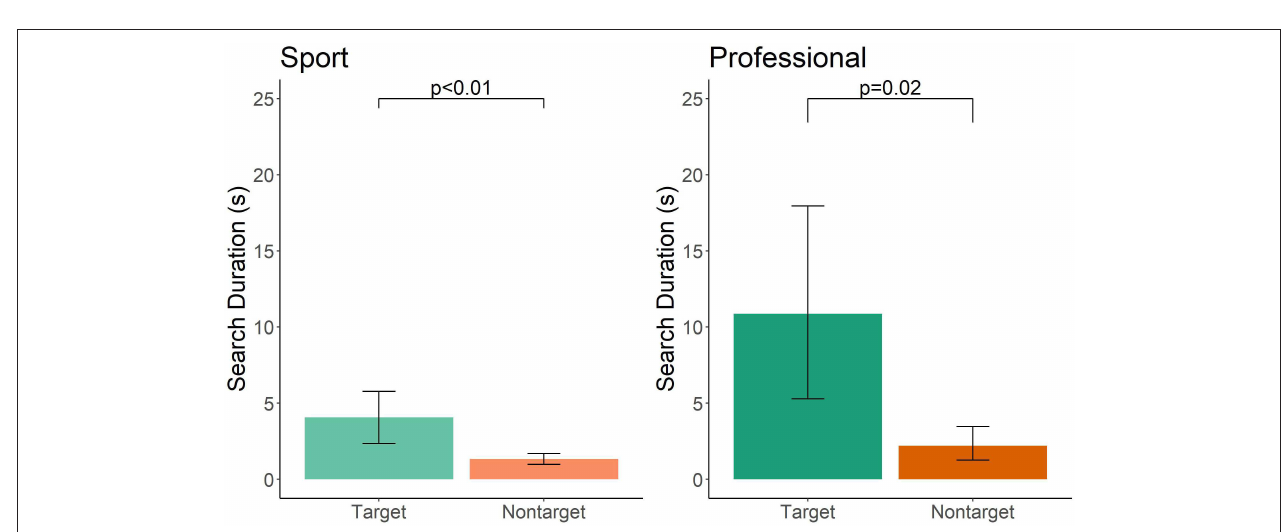
FIGURE 2 | Target vs. non-target investigation duration in sport and professional handler dog teams. Error bars represent 95% confidence intervals.